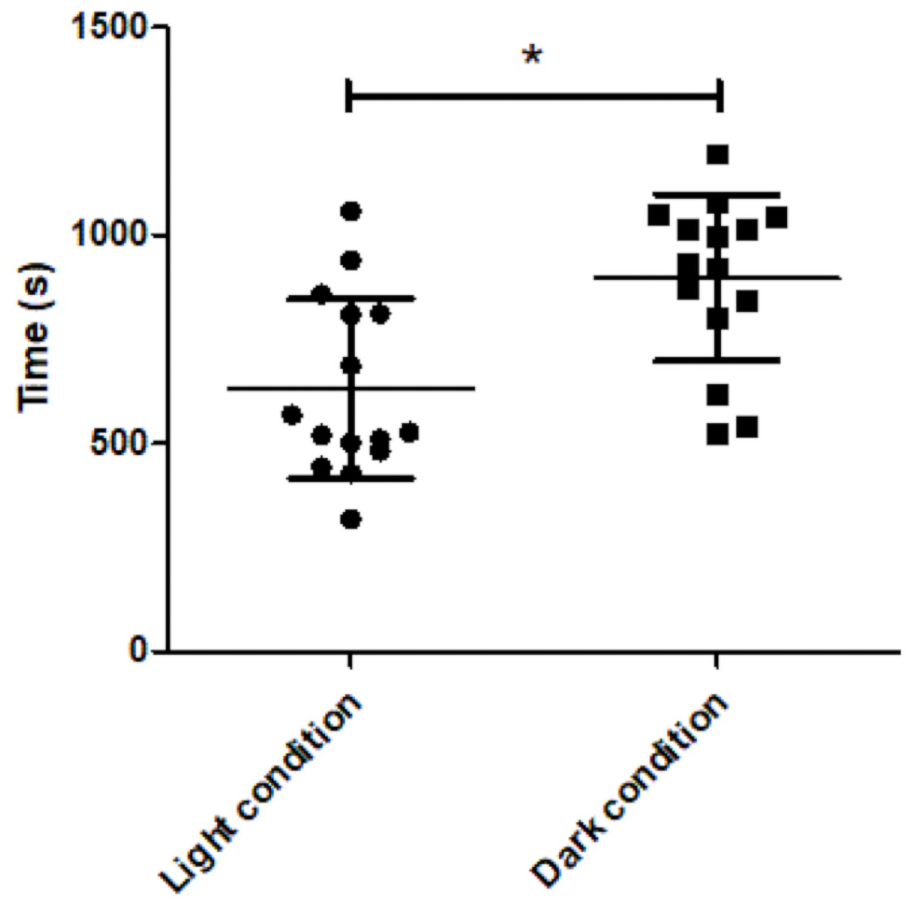
Fig 3. Animals activity. Individual values of the activity recorded over 30 min under light (circles) and dark (squares) conditions. Statistically significant differences are found between these two groups ( � p < 0.05).